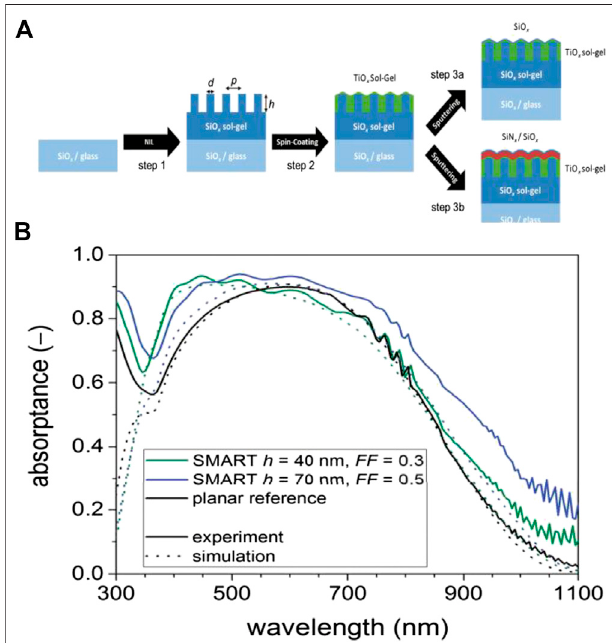
FIGURE 17 | (A) the fabrication process of SMART texture of crystalline Silicon. (B) Comparison of absorption in 11 μ m thick layers of silicon for two different nanostructures with lower (green) and higher (blue) fi lling fraction (FF) and height (h) as well as a planar reference interlayer stack (black). The experimental structures (solid) are compared to a 1-dimensional effective medium model with scattering model (dotted). Source : Reproduced from Ref.